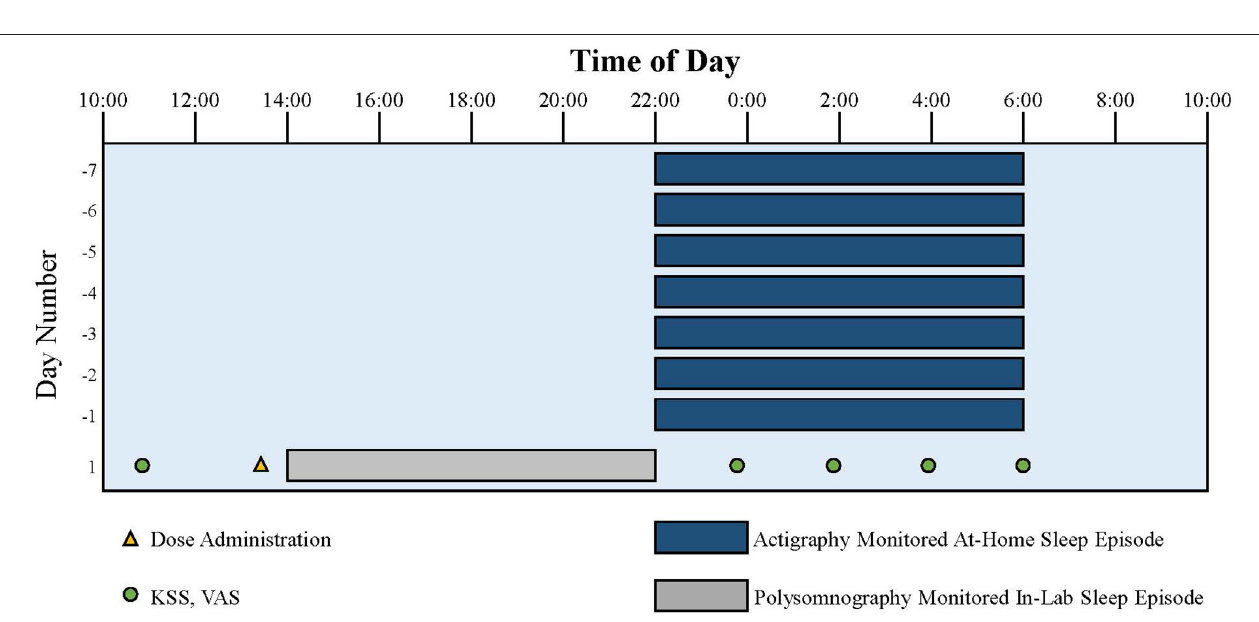
FIGURE 1 | The study consisted of a 1–4 week screening period followed by an evaluation visit where patients were dosed with tasimelteon 20mg or placebo 30-min prior to their pre-determined 8-h phase advance bedtime. Polysomnography was performed during the 8-h sleeping period. Karolinska Sleepiness Scale (KSS) and Visual Analog Scale (VAS) assessments were completed once during screening, once before the phase advance, and four times after waking.